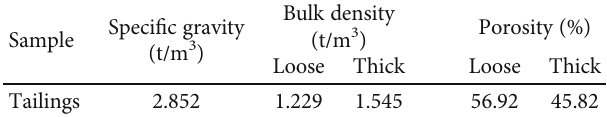
Figure 1: Rock mechanics test system. Table 1: Basic physical properties of tailings.